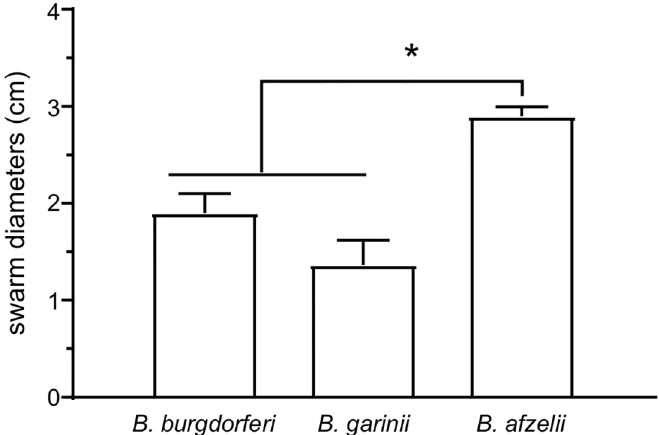
Fig 2. Motility of the three strains. Motility was measured in diluted BSK-II agar plates supplemented with 0.35% agarose. Swarm diameters were measured after 4d of incubation at 34˚C in microaerobic conditions. Results reported are the average of three independent experiments. Data represent means ± standard deviation. An asterisk indicates a significant difference using a one-way ANOVA where p < 0.05.